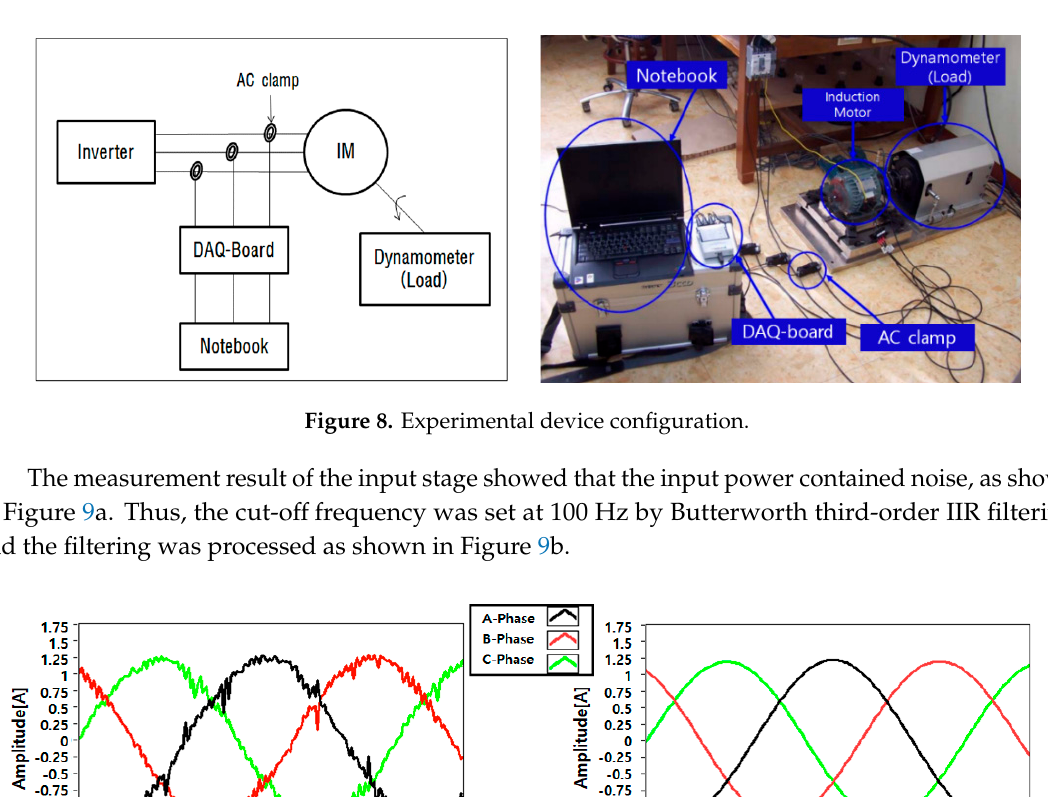
Figure 10. Method for configuring artificial turn short circuits: ( a ) short circuit of stator winding, ( b ) external tab of the turn short circuit motor. Table 2 shows a turn-to-turn short circuit according to the tab connection. It shows the ITSC when turns no. 1–3 were connected. When turn no. 5 was connected, the turn-to-turn short circuit increased to a 4-turn short.